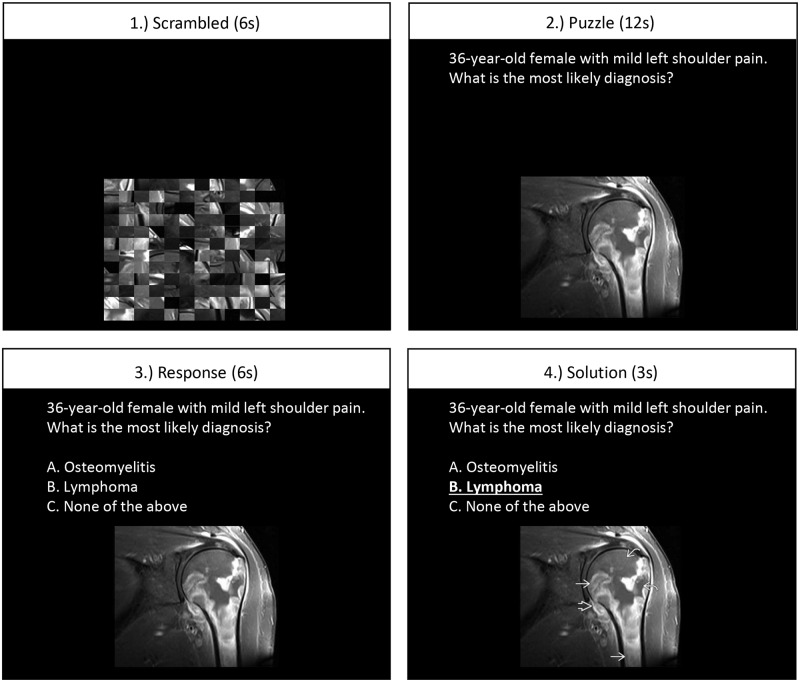
fMRI task paradigm.